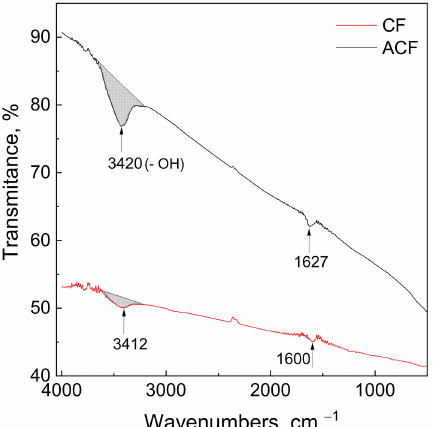
Figure 2. Fourier transform infrared spectroscopy spectra of carbon fibers before and after chemi- cal